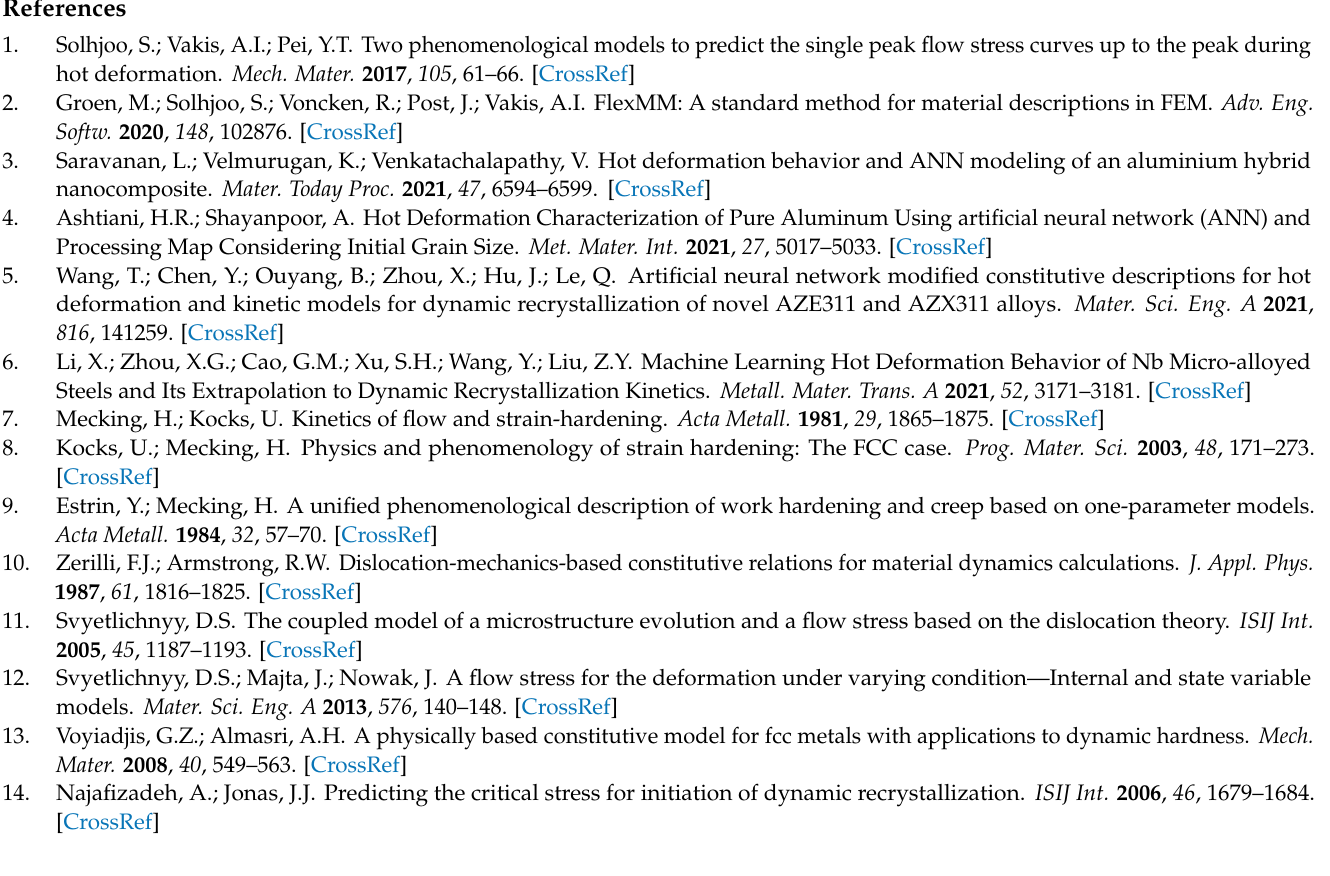
Figure A6. The comparison between the measured stresses and their estimations using a trained ANN. The stress–strain curves are shown for different temperatures and strain rates of ( a ) 0.01 s − 1 , ( b ) 0.1 s − 1 , and ( c ) 1 s − 1 . ( d ) The correlation between σ m and σ p